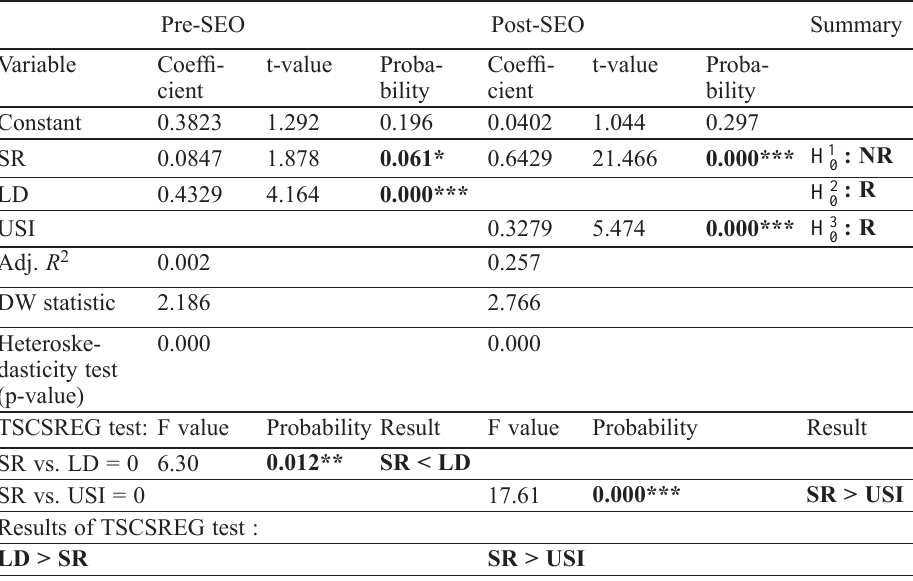
Table 10. Robustness checking: Two-way random effects model of Latin American markets – excluding insigni fi cant variables in initial model Pre-SEO Post-SEO